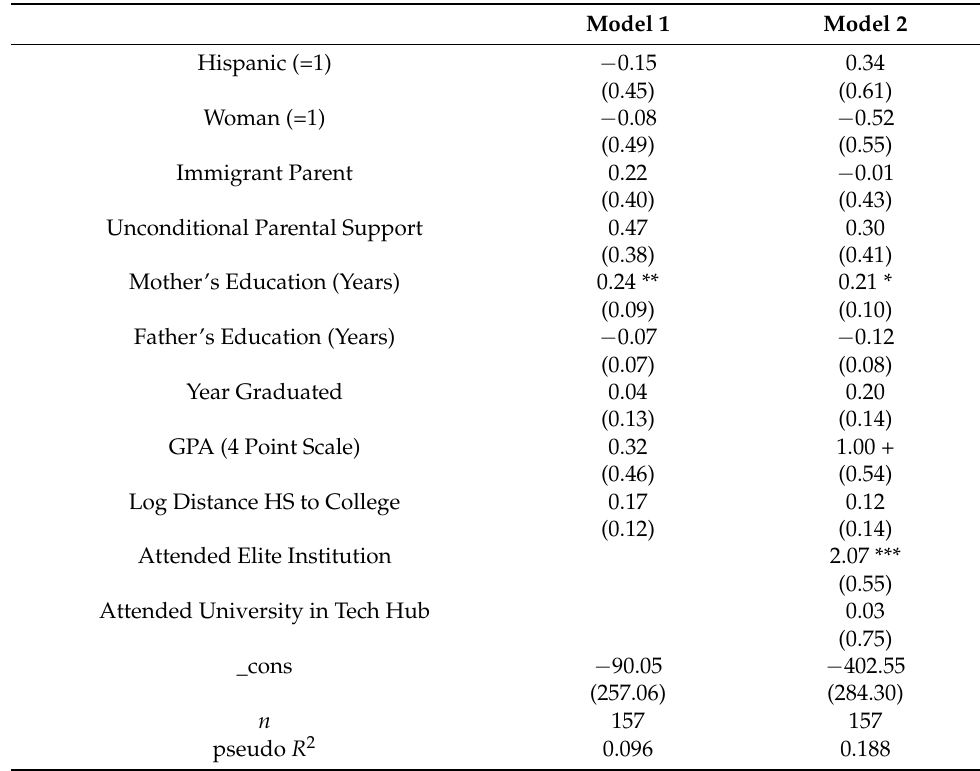
Table 4. Predictors for working in a degree-relevant occupation among recent CS degree recipients in Texas,